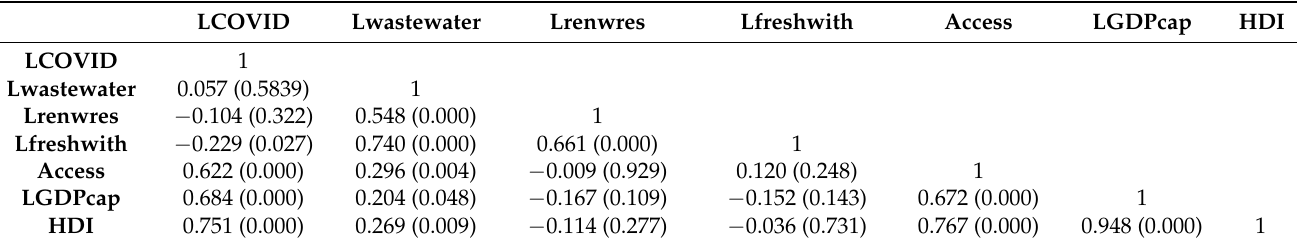
Table 2. Correlation